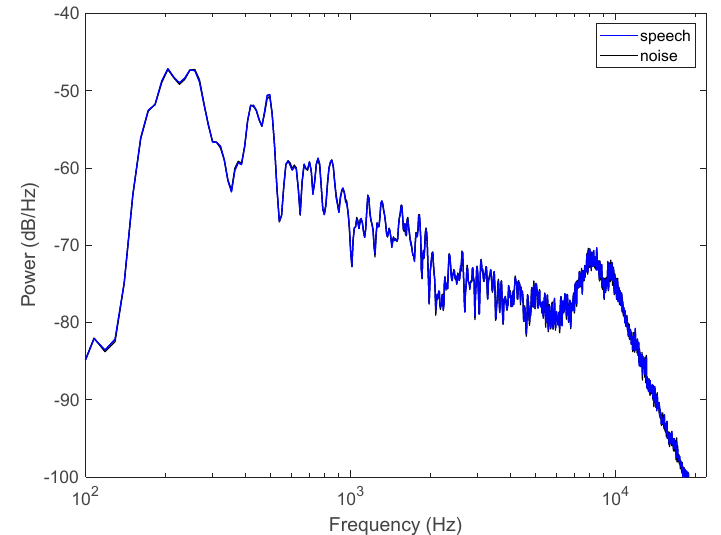
Figure 1. Power spectral density of the digital speech and noise signals.